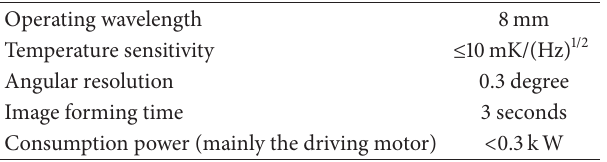
Table 2: The technical specifications of the 8mm imaging system.